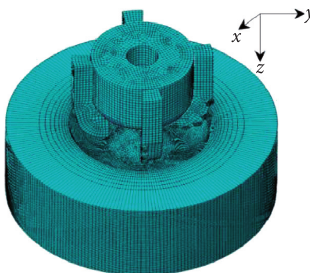
Figure 10: The finite element model of the conventional PDC bit-rock.